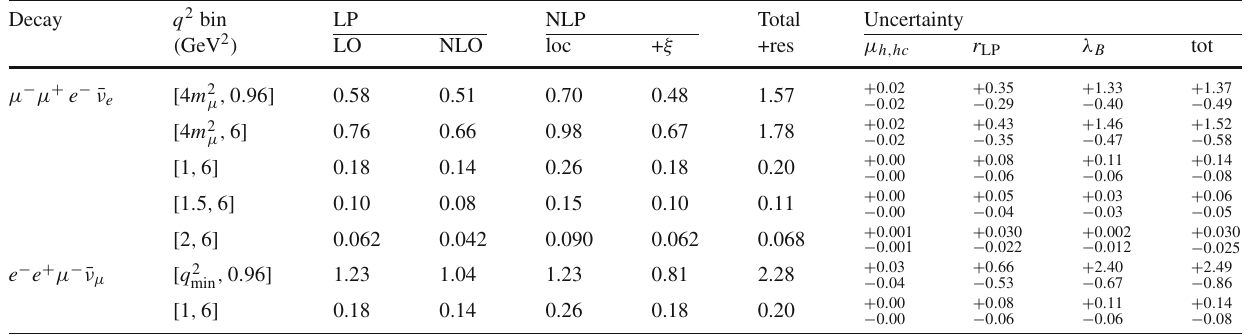
In addition, we quote the uncertainties from varying the scales μ h , hc , r obtained by adding them in quadrature. For electrons, we also consider = 0 . 0025 GeV a low bin with q 2 min